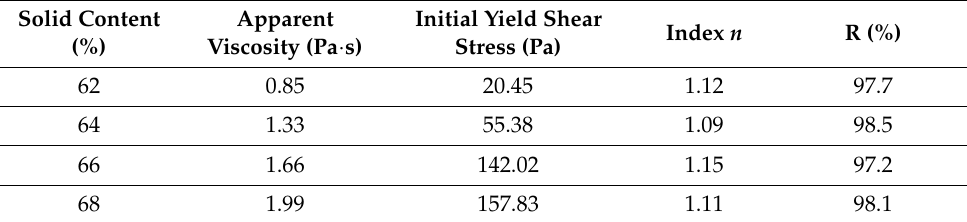
Table 5. Fitting equation parameters of UCPB with ultrasonic wave action.